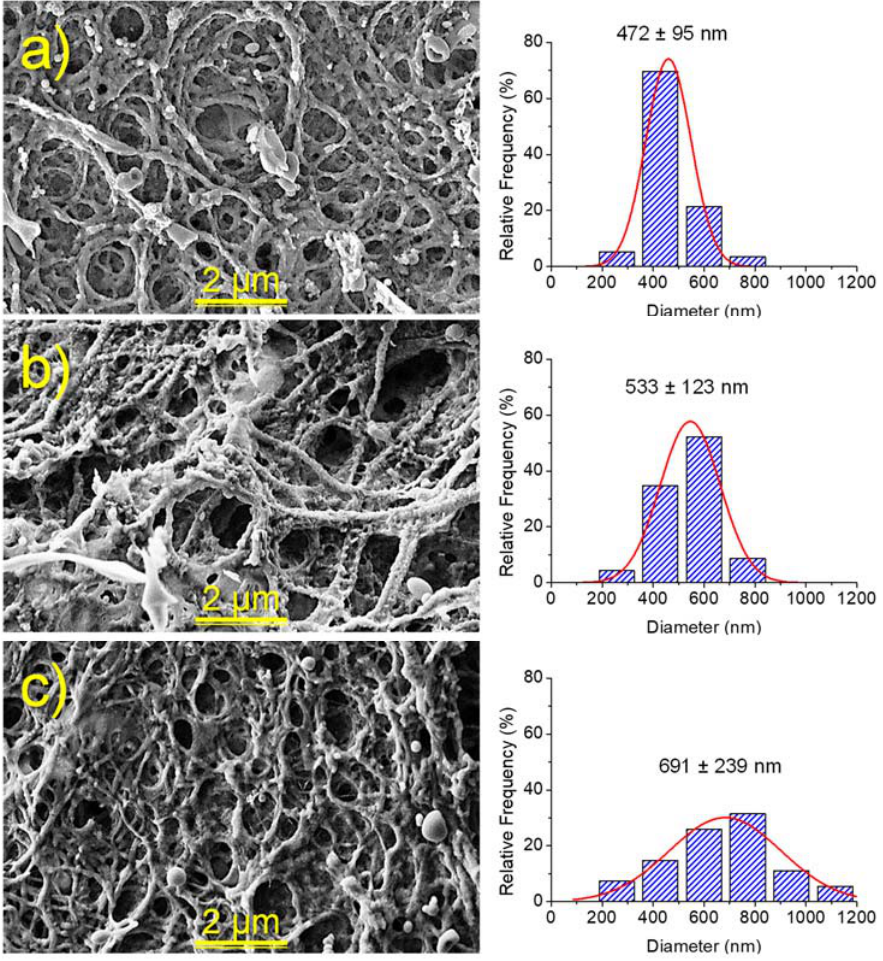
Figure 8. SEM micrographs ( left ) comparing the morphology of hydrogels from electrospun nano ‐ fibers and a crosslinking process involving 50% ( a ), 75% ( b ) and 100% ( c ) of the steochiometric amount of cystamine. Fiber diameter distributions are provided in the